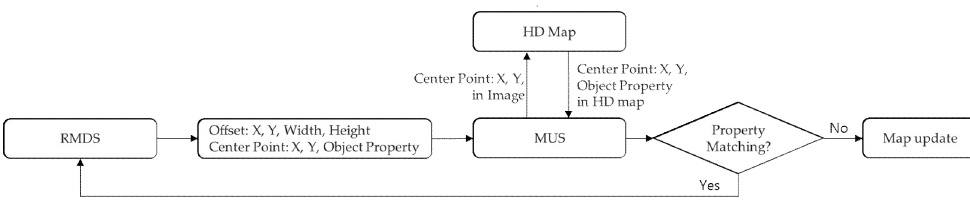
Figure 16. Flowchart of MUS that determines whether to update by comparing the RMDS detection result and the data in the HD Map.